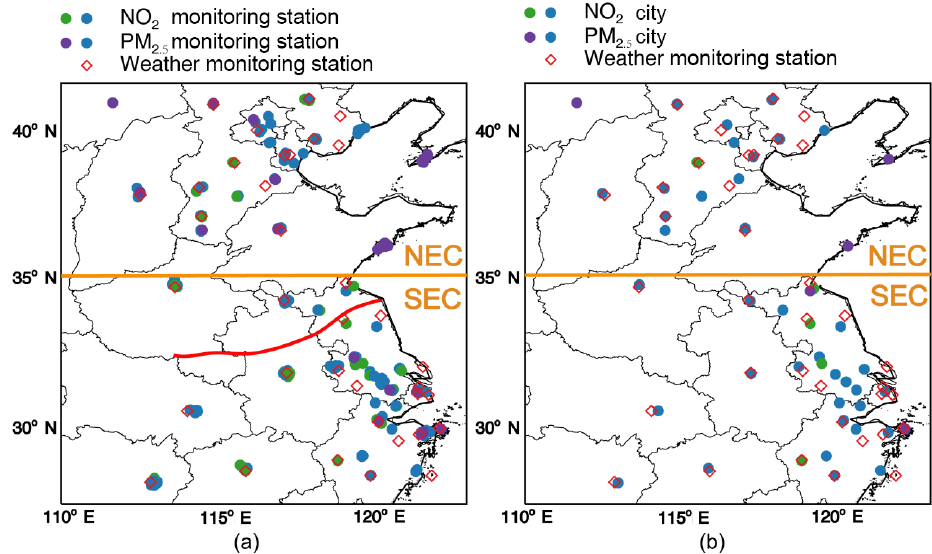
Figure 1. (a) Distribution of 163 measurement stations for NO 2 , 157 stations for PM 2 . 5 , and 36 meteorological stations (red diamonds) over Eastern China (25–41 ◦ N, 110–123 ◦ E). (b) Distribution of 42 cities with NO 2 and PM 2 . 5 observations. Both dots denote stations (a) and cities (b) with both NO 2 and PM 2 . 5 data. The blue dots indicates the same stations (cities) for both NO 2 and PM 2 . 5 , while the green dots are only used for NO 2 and purple dots are only used for PM 2 . 5 . The orange line separates northern Eastern China (NEC) and southern Eastern China (SEC), and the red line labels the location of the Huai